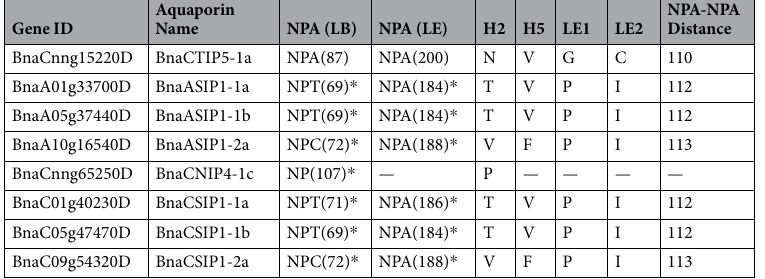
Table 2. Details of NPA motifs and ar/R selectivity filters in aquaporins identified in Brassica napus . NPA motifs were identified using CDD search at NCBI. The NPA motifs with an asterisk ( * ) initially failed to be identified with CDD search and were then identified with manual evaluation of protein sequence